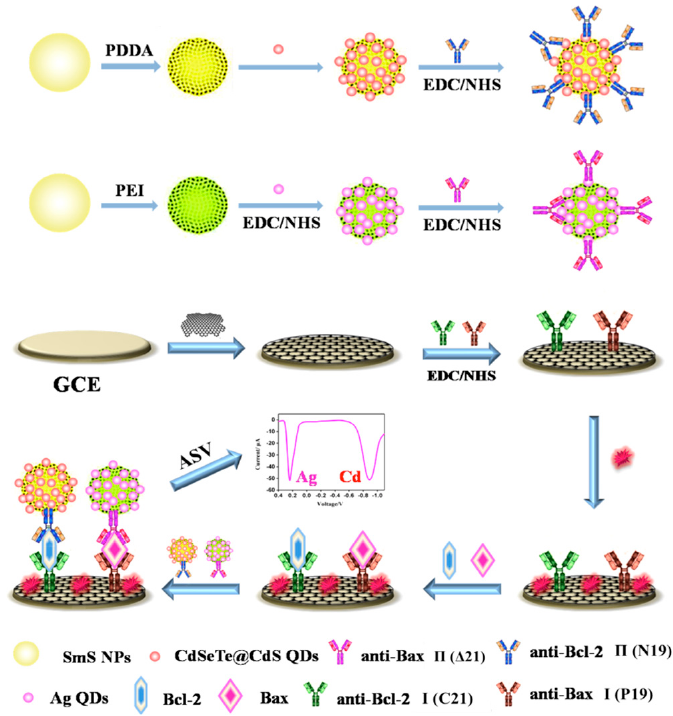
Figure 12. Fabrication of the dual-signal-marked electrochemical immunosensor for the detection of Bcl-2 and Bax. First, reduced graphene oxide (RGO) was used to modify glassy carbon electrode (GCE) to increase surface area and then linked antibodies I of Bcl-2, Bax. After bovine serum albumin (BSA) protein block the nonspecific adsorption sites, the electrode was immersed into the mixed antigens to capture the active Bcl-2 and Bax proteins. Finally, the electrode was reacted with antibody Π -targeted QDs and Ag nanoclusters as the signal probes, which were proportional to targets on the electrode. Reproduced with permission from [86].